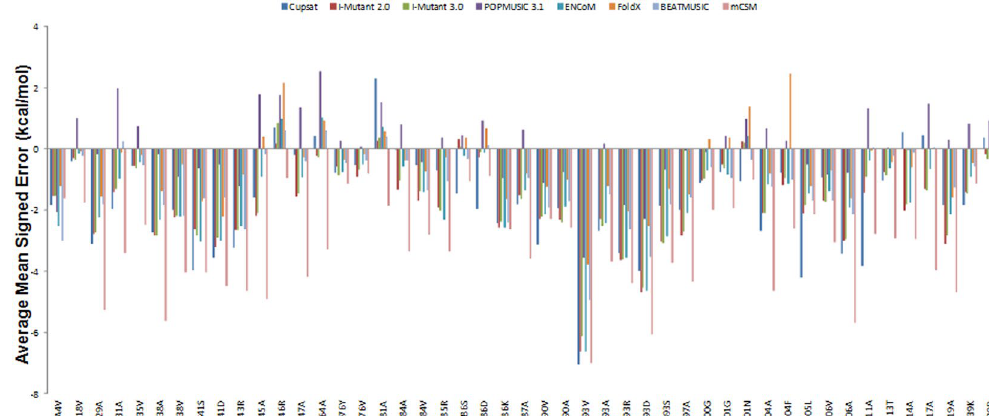
Figure 3. Analysis of complicated sites. Mean signed errors (kcal/mol) averaged over all four structures for each eight methods, decomposed into individual